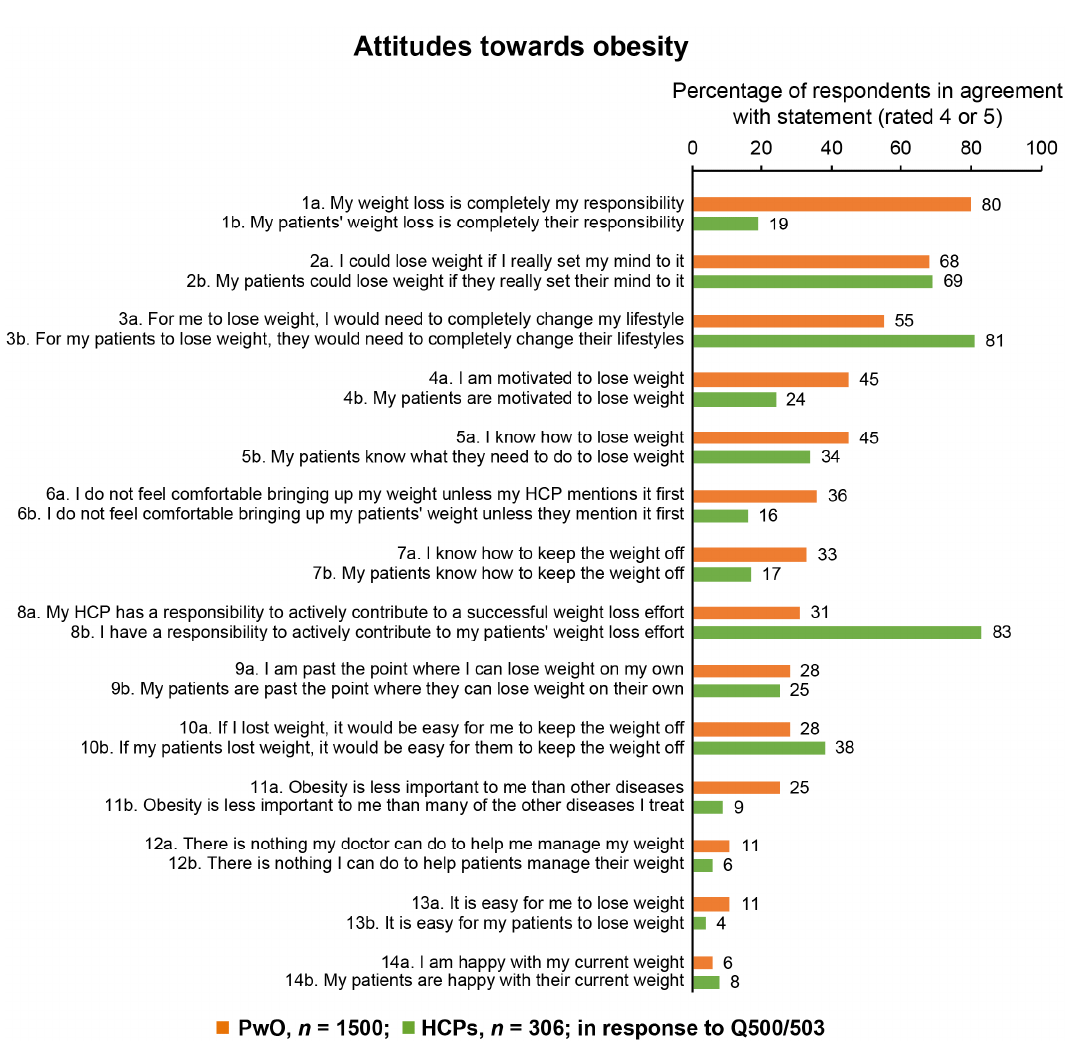
Figure 1. PwO and HCP agreement with statements regarding attitudes towards obesity. PwO = orange; HCPs = green. HCP, healthcare professional; PwO, people with obesity. Rated on a scale of 1–5.